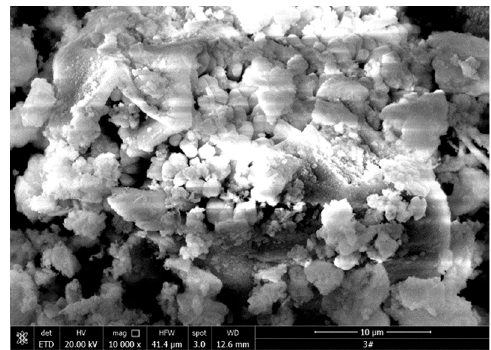
Figure 17. SEM of the leaching residue.